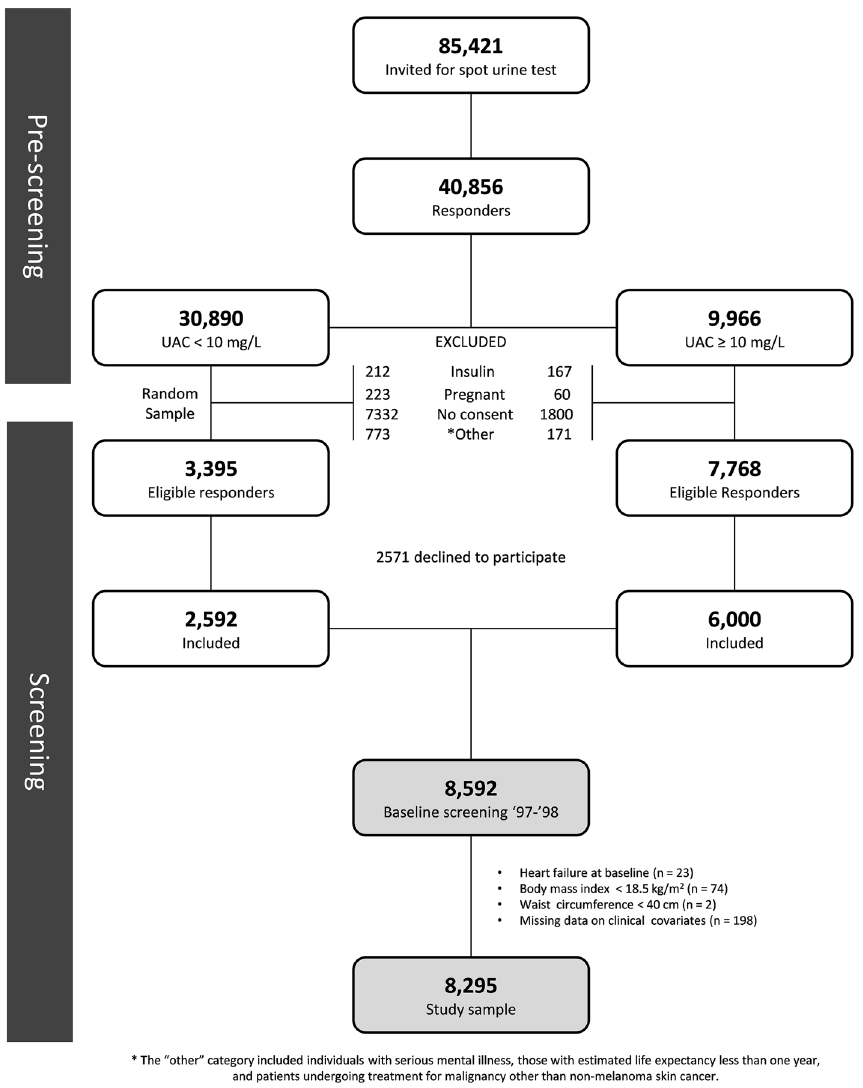
Figure 1. Flow diagram: participant selection in the PREVEND